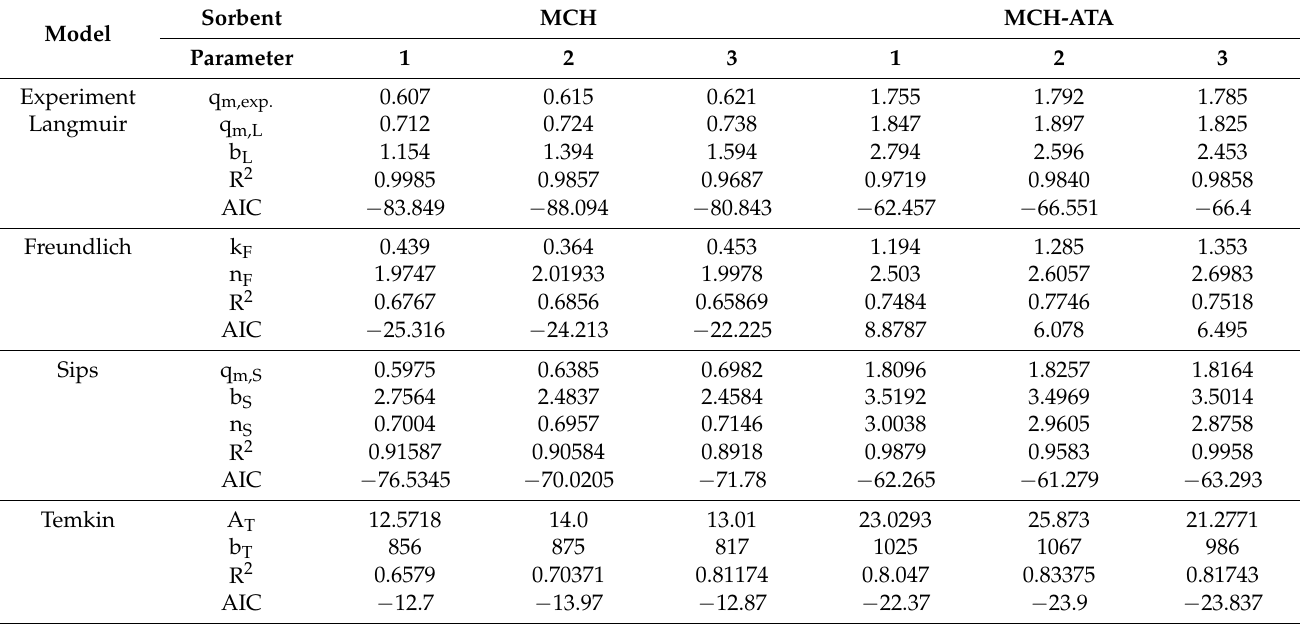
Figure 8. Average values of Langmuir and Sips modeling equations for Cd(II) sorption (with error bars) for MCH and MCH-ATA sorbents. Table 3. Modeling of Cd(II) sorption isotherms of MCH and MCH-ATA sorbents at pH 0 5. Parameters of Langmuir, Freundlich, Sips and Temkin